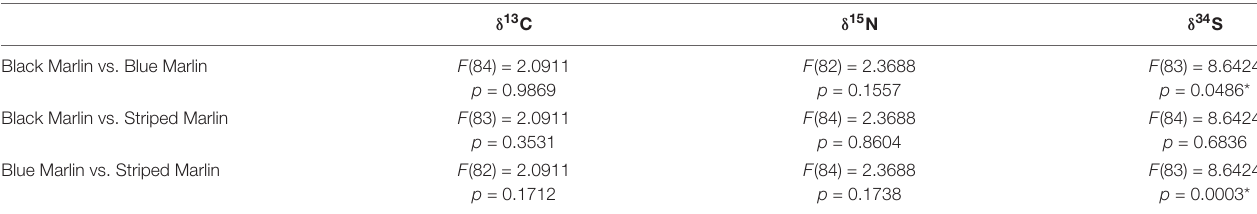
F (82) = 2.3688 p = 0.1557 F (84) = 2.3688 p = 0.8604 F (84) = 2.3688 p = 0.1738